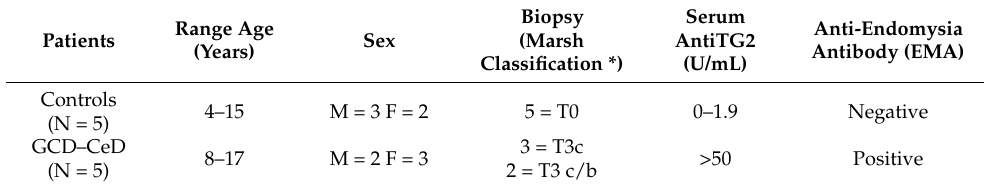
Table 2. Organoids